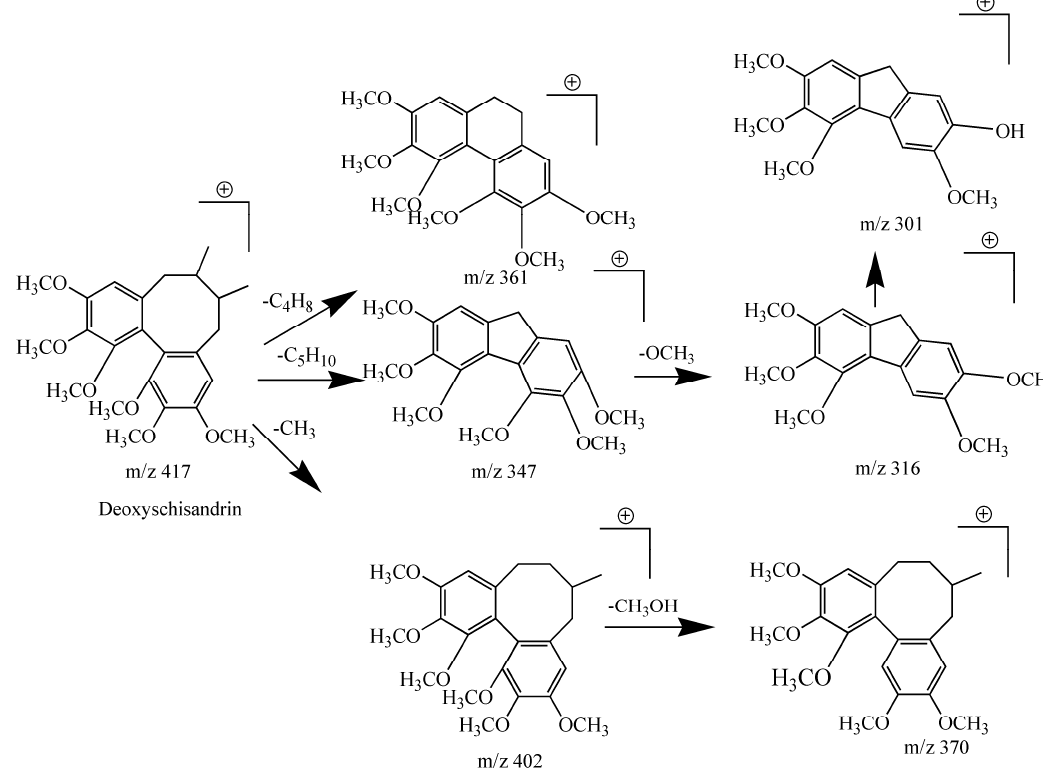
Figure 2. The proposed fragmentation pathway of deoxyschisandrin in positive ion mode.